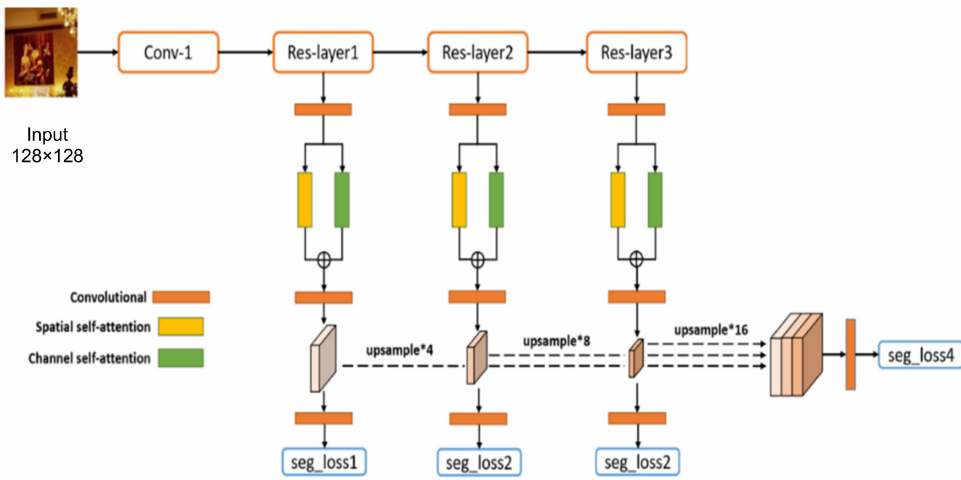
Figure 2. The proposed network architecture. The input is an image with the size 128 × 128, and the network outputs a tampered possibility map with the same